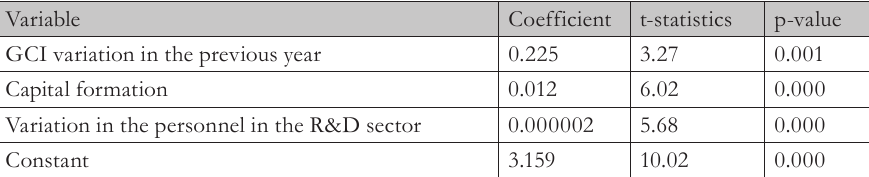
Tab. 5 − Determinants of GCI variation in the EU (2004-2018) (System GMM estimation).